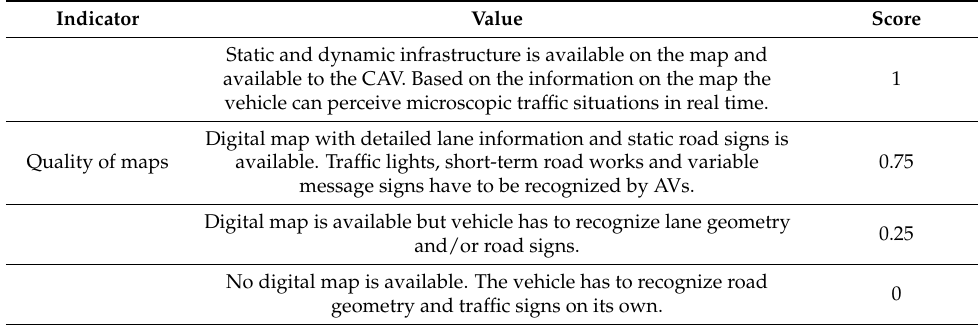
Table 4. The assessment framework—quality of maps area. Indicator